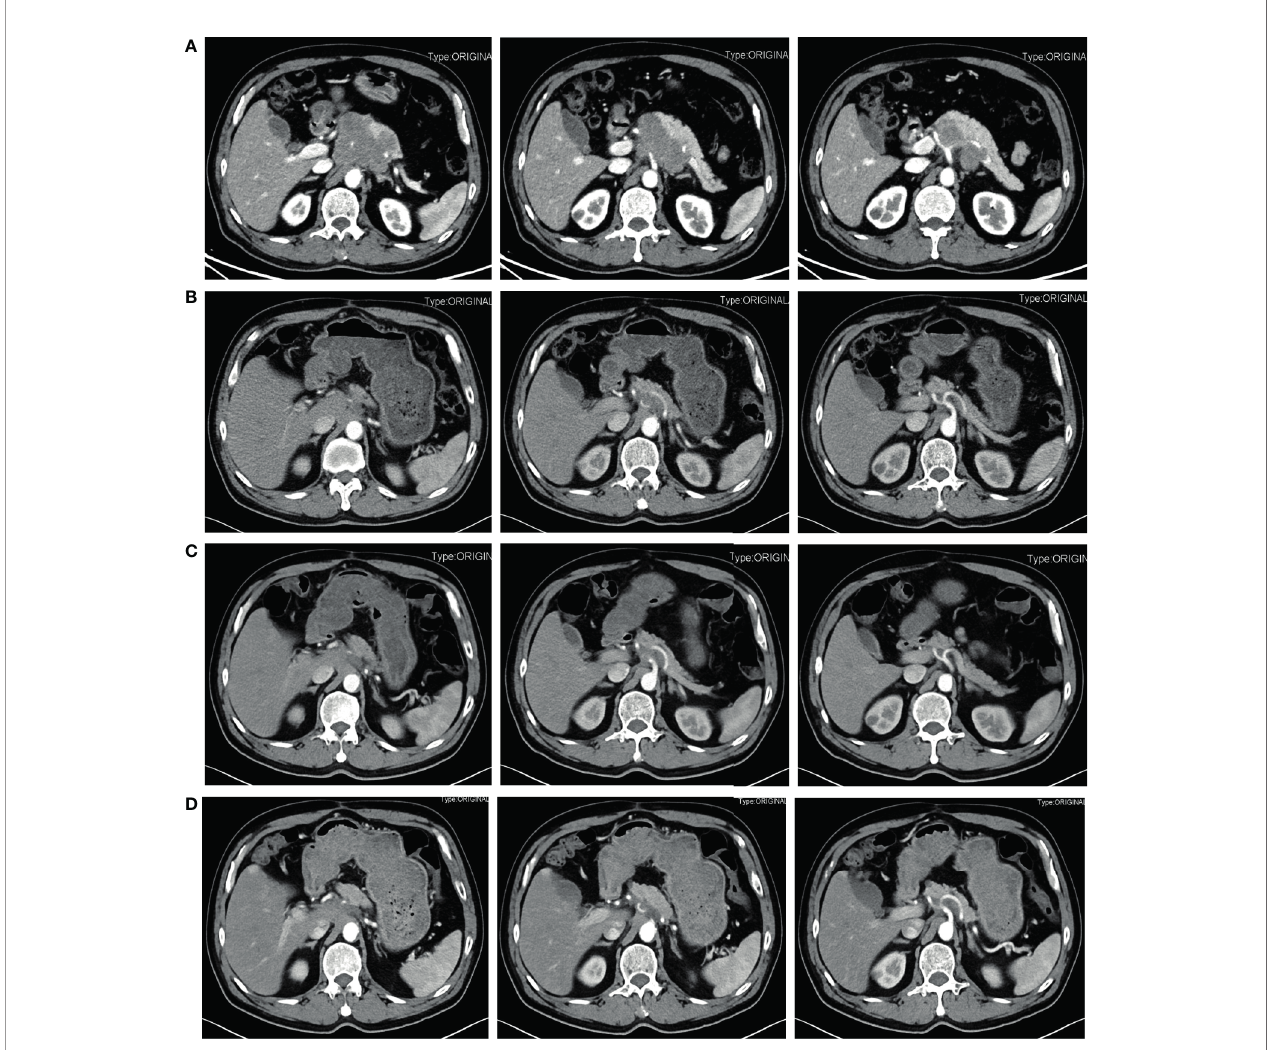
FIGURE 1 | Contrast-enhanced abdominal CT during treatment before the radical surgery. (A) Pretreatment. A retroperitoneal neoplastic lesion measuring about 6.5 cm x 8.3 cm was observed, which was located on the head and neck of the pancreas and manifested a moderate enhancement. The left gastric artery and splenic artery were covered in the tumor, and the common hepatic artery and the celiac trunk were got invaded. (B) 3 months after four courses of etoposide plus cisplatin neoadjuvant chemotherapy. The tumor size was signi fi cantly reduced and limited to 2.7 cm x 2.3 cm. (C) 5 months after four courses of etoposide plus cisplatin neoadjuvant chemotherapy. The tumor size was limited to 2.7 cm x 2.3 cm. (D) After six courses of neoadjuvant chemotherapy. The tumor size reached 3.0 cm x 2.2